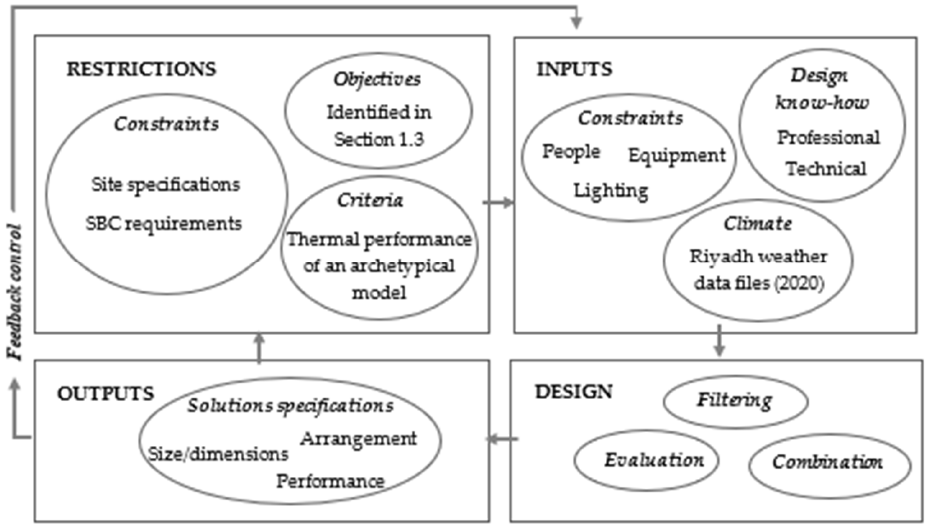
Figure 2. The retrofit approach ‐ tailored energy modelling methodology flowchart.